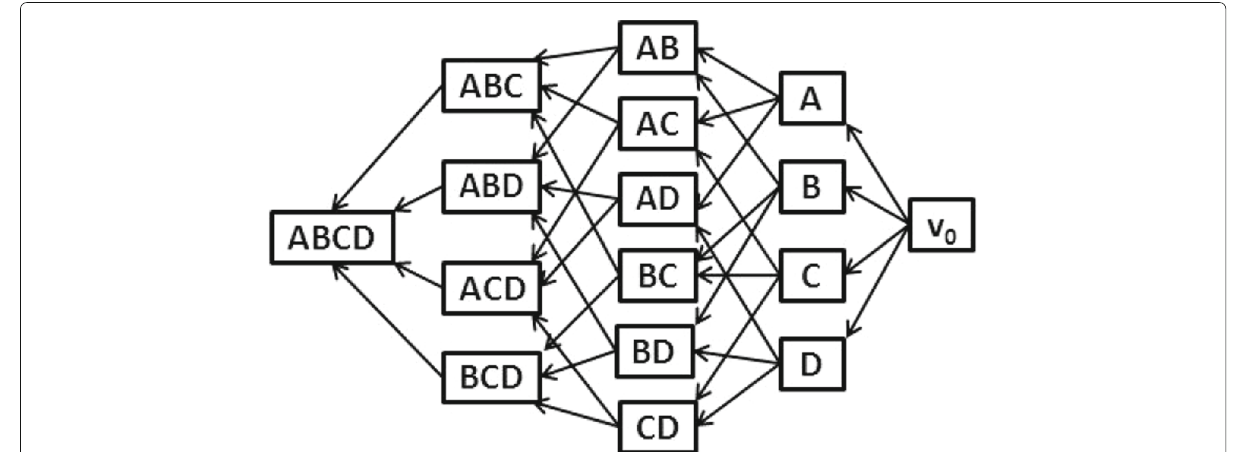
Fig. 6 A user graph over a set { A , B , C , D } of four users